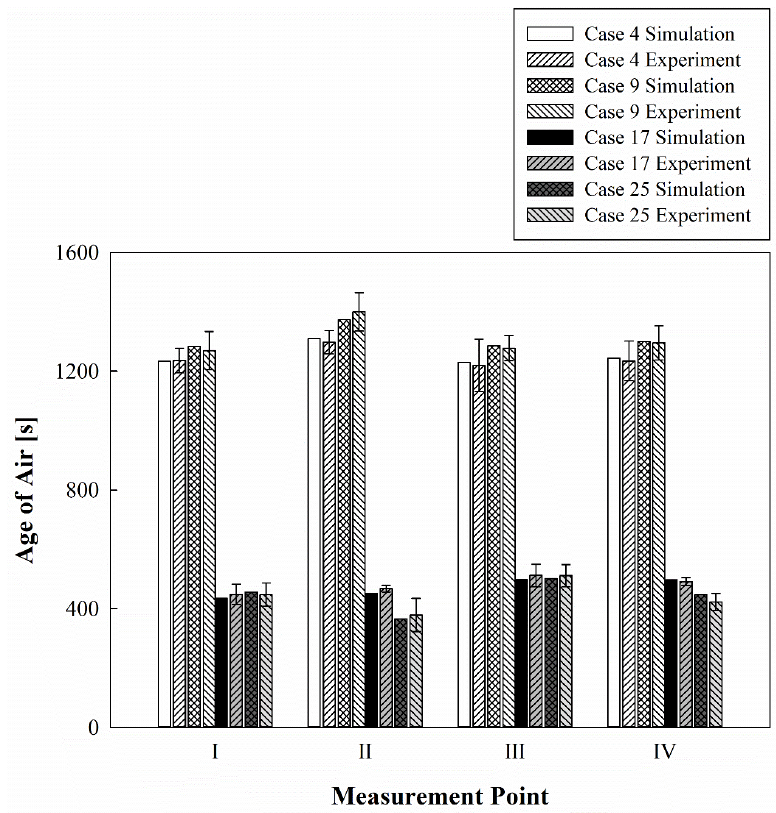
Figure 4. Comparative verification results of experimental measurements and numerical analysis.